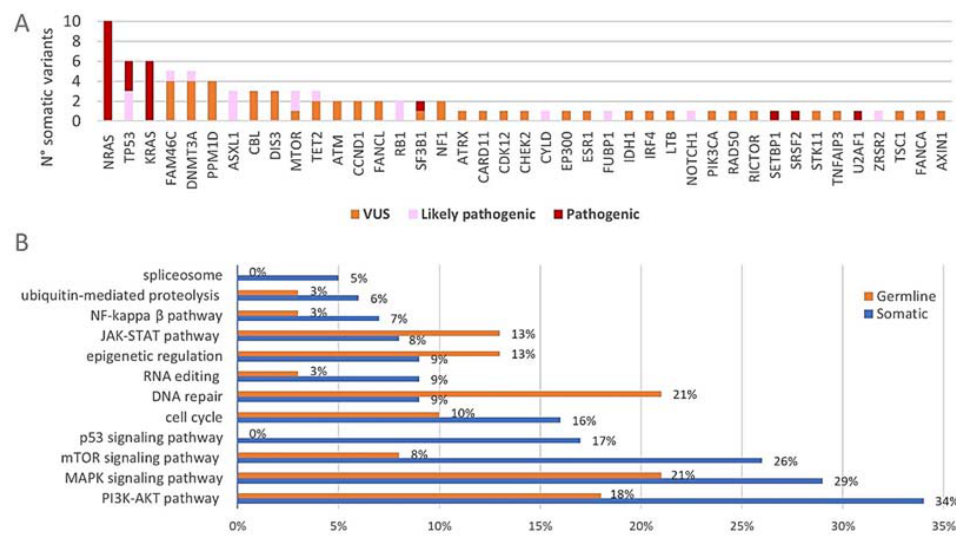
Figure 3. ( A ) Distribution of the somatic variants across the 165-gene panel. The absolute number of somatic variants ( n = 87) in each of the 41 of 165 genes that carried mutations is shown. The pathogenicity of each variant is indicated with different colors. ( B ) Proportional involvement of genetic pathways by somatic and germline variants. The percentages of somatic ( n = 87) and germline ( n = 39) variants affecting each of the indicated pathways are shown in the graph. Some genes act in multiple pathways and are counted accordingly .